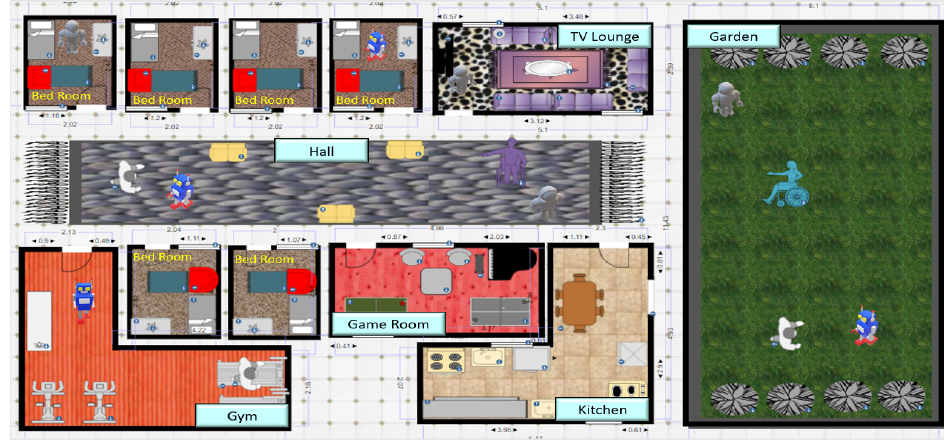
Figure 3. Aged-Care Center Domain consisting of multiple robots, with seniors and